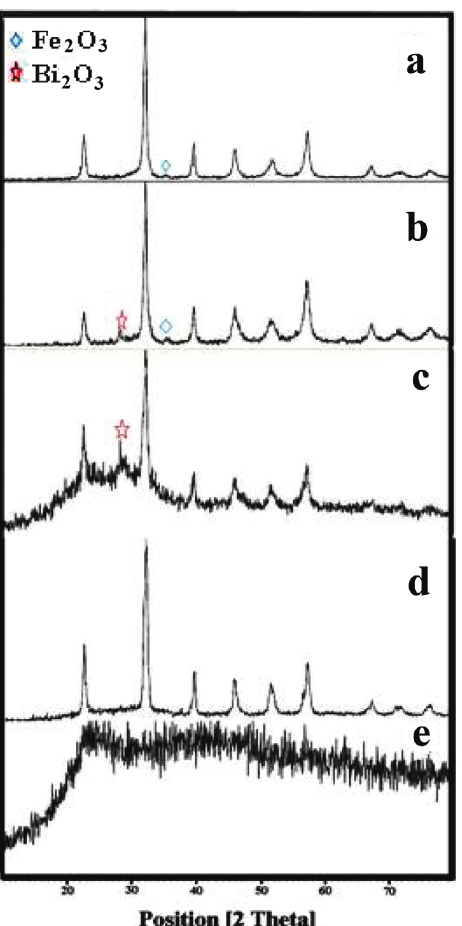
Figure 2: XRD pattern of bismuth ferrite prepared by (a) Pechini, (b) microwave, (c) assisted by PVP, (d) assisted by chitosan after calcination, and (e) assisted by chitosan before calcinations.